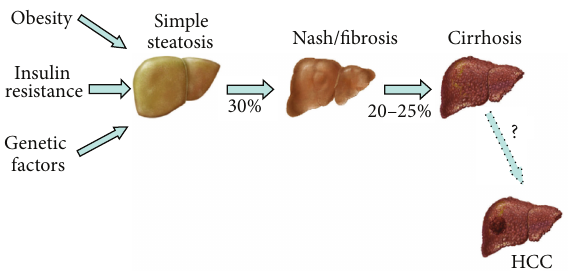
Figure 1: Spectrum of NAFLD. Obesity, genetic factors, and insulin resistance (IR) contribute to fat deposition in the liver. Approxi- mately 30% of patients with NAFLD have NASH, which involves the presence of various degrees of inflammation and fibrosis, and can progress to cirrhosis in 20–25% of cases within 20 years. An unknown percentage of cases develop HCC. Adapted from Trauner et al., 2010